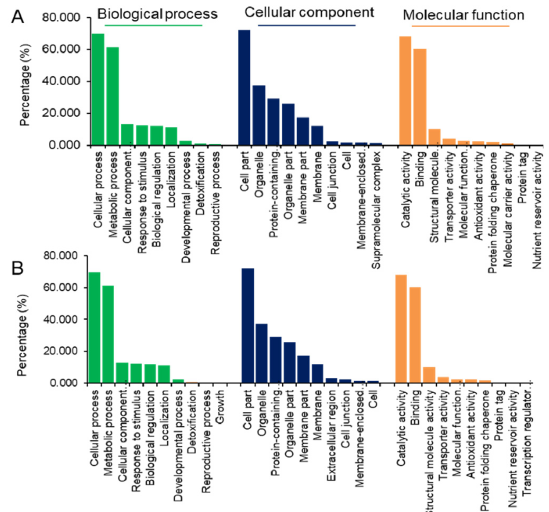
Figure 2. Functional categorization of identified proteins using the gene ontology (GO) database. The protein sequence was blasted against the GO database using blast2go v4.5 pipeline software. The protein function was predicted in categories including biological process, cell component, and molecular function. ( A ) Functional categorization of proteins identified from Nigeria-sourced samples. ( B ) Functional categorization of proteins identified from Ghana-sourced samples. With respect to the significantly changed proteins, aside from their broad functional categorization and carbohydrate transport to secondary metabolites biosynthesis (Figure 3).